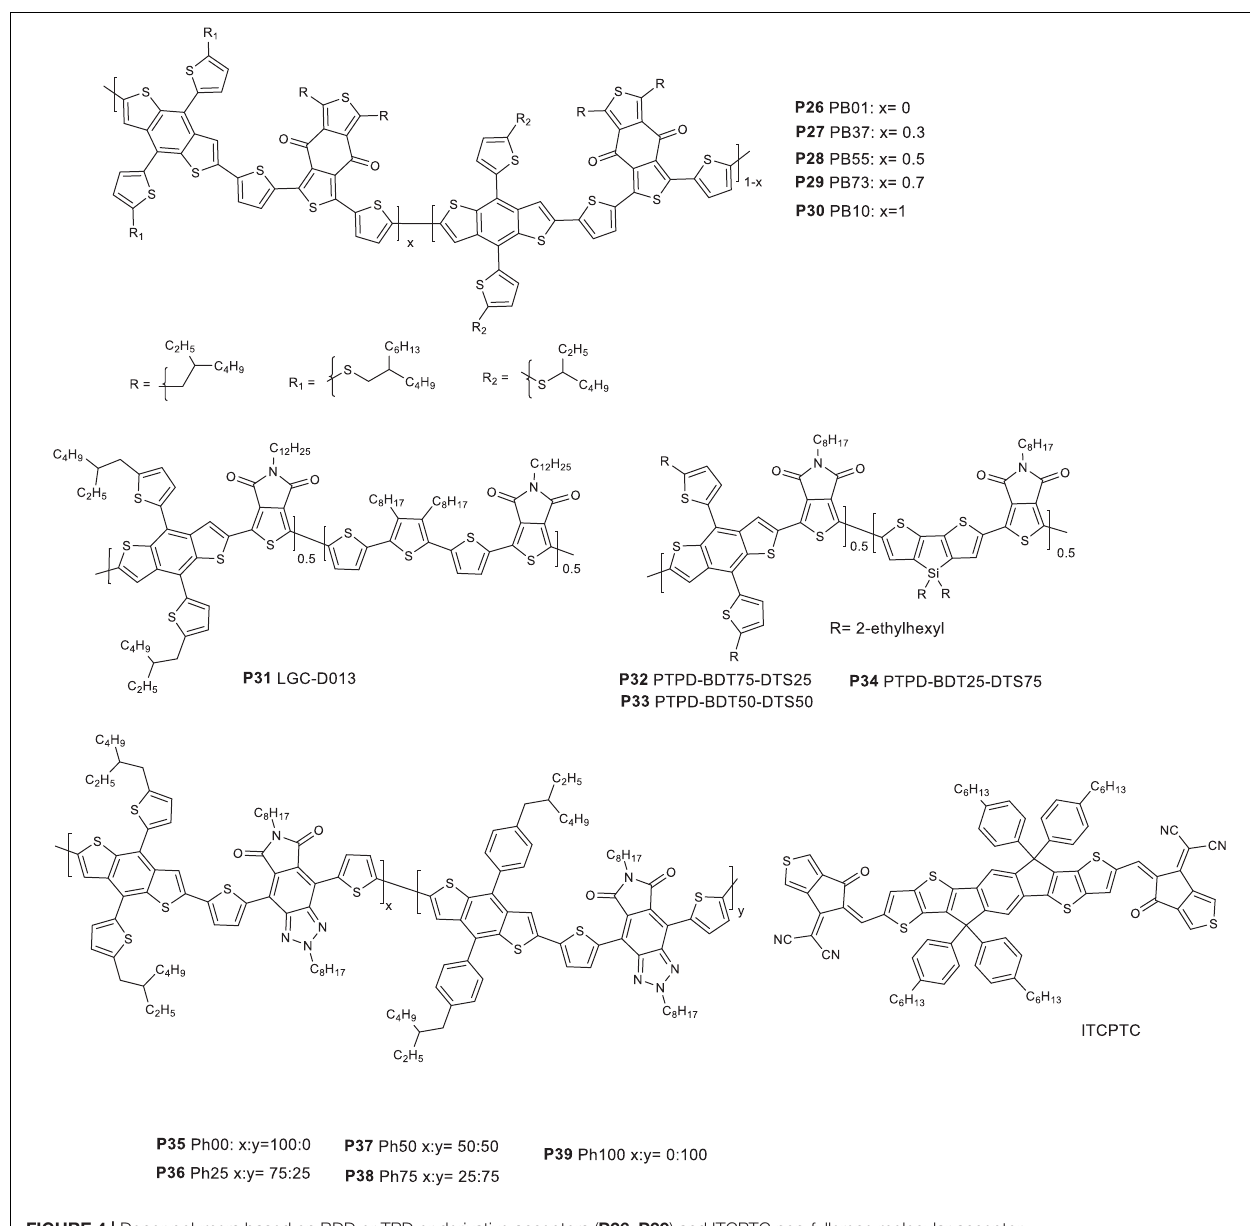
FIGURE 4 | Donor polymers based on BDD or TPD or derivative acceptors ( P26–P39 ) and ITCPTC non-fullerene molecular